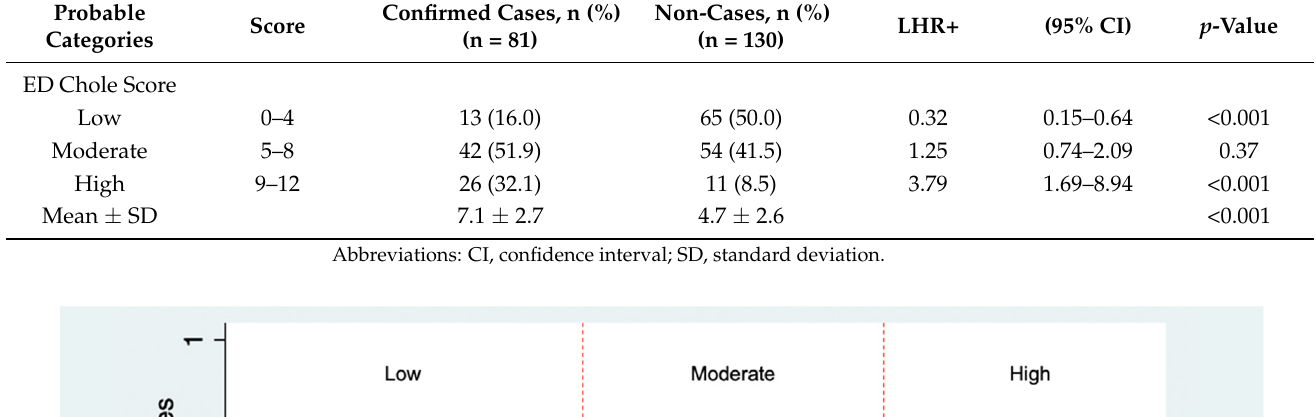
Table 4. Score categorization and likelihood ratio of positive (LHR+) in ED Chole Score.